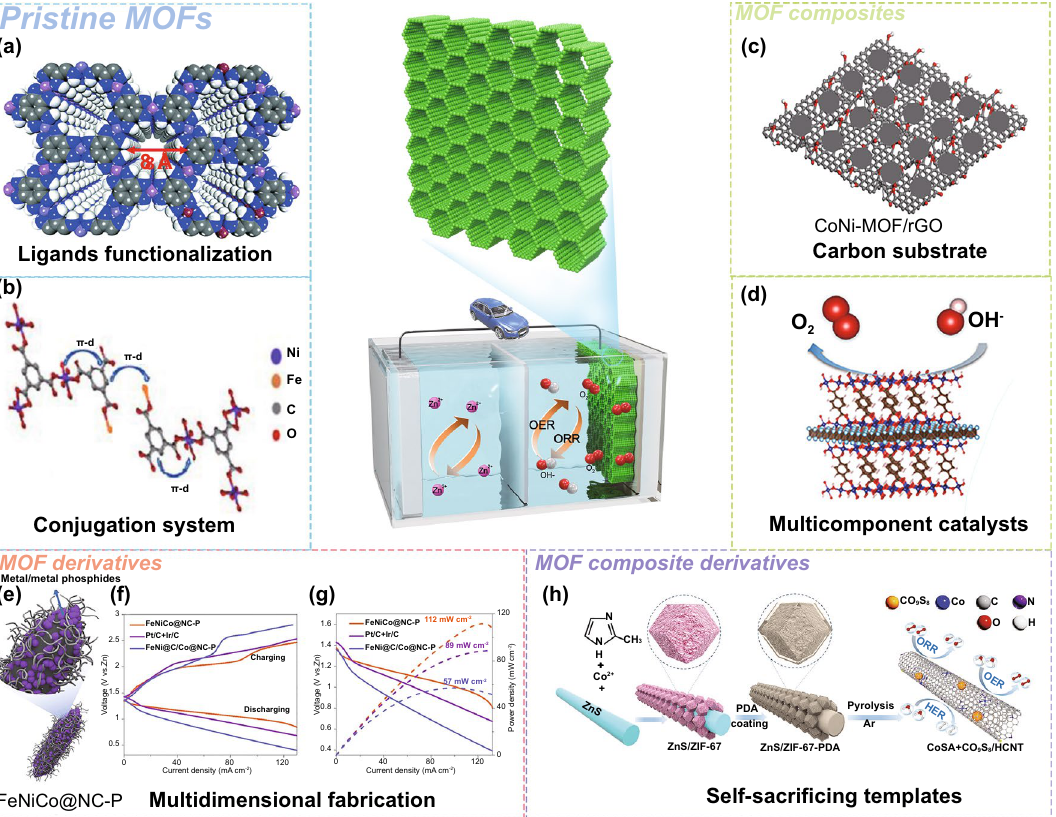
Fig. 6 MOF-based materials for Zn–air batteries. a Structure illustration of 3D M-HIB-MOFs [176]. Copyright © 2019, Royal Society of Chemistry. b Illustration of conjugation system of Ni/Fe-BTC MOFs [177]. Copyright © 2019, Elsevier. c Structure illustration of the CoNi- MOF/RGO catalyst [179]. Copyright © 2019, American Chemical Society. d Structure of Ti 3 C 2 T x − CoBDC hybrid [182]. Copyright © 2017, American Chemical Society. e Schematics of preparation of FeNiCo@NC-P. f Charge–discharge profiles, g discharge curves and the correspond- ing power density curves of FeNiCo@NC-P, FeNi@C/Co@NC-P and the mixture of Pt/C + Ir/C, respectively. [189]. Copyright © 2019, Wiley– VCH. h Illustration of synthetic strategy of CoSA + Co 9 S 8 /HCNT [27]. Copyright © 2020,